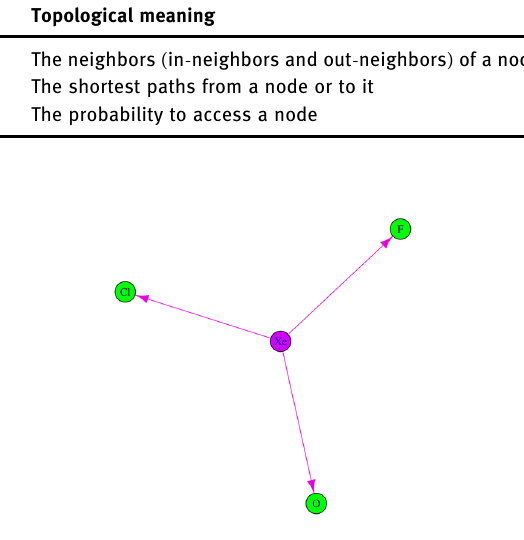
Figure 1: A directed network of Xe and its edges in a